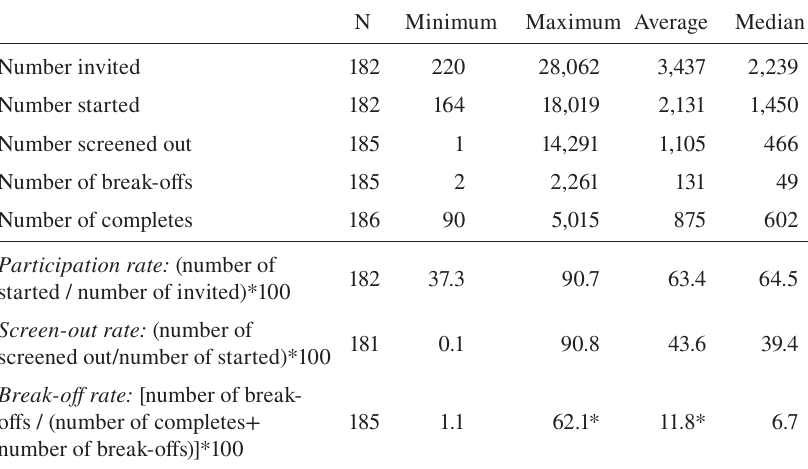
Survey participation: from invitation to completion N